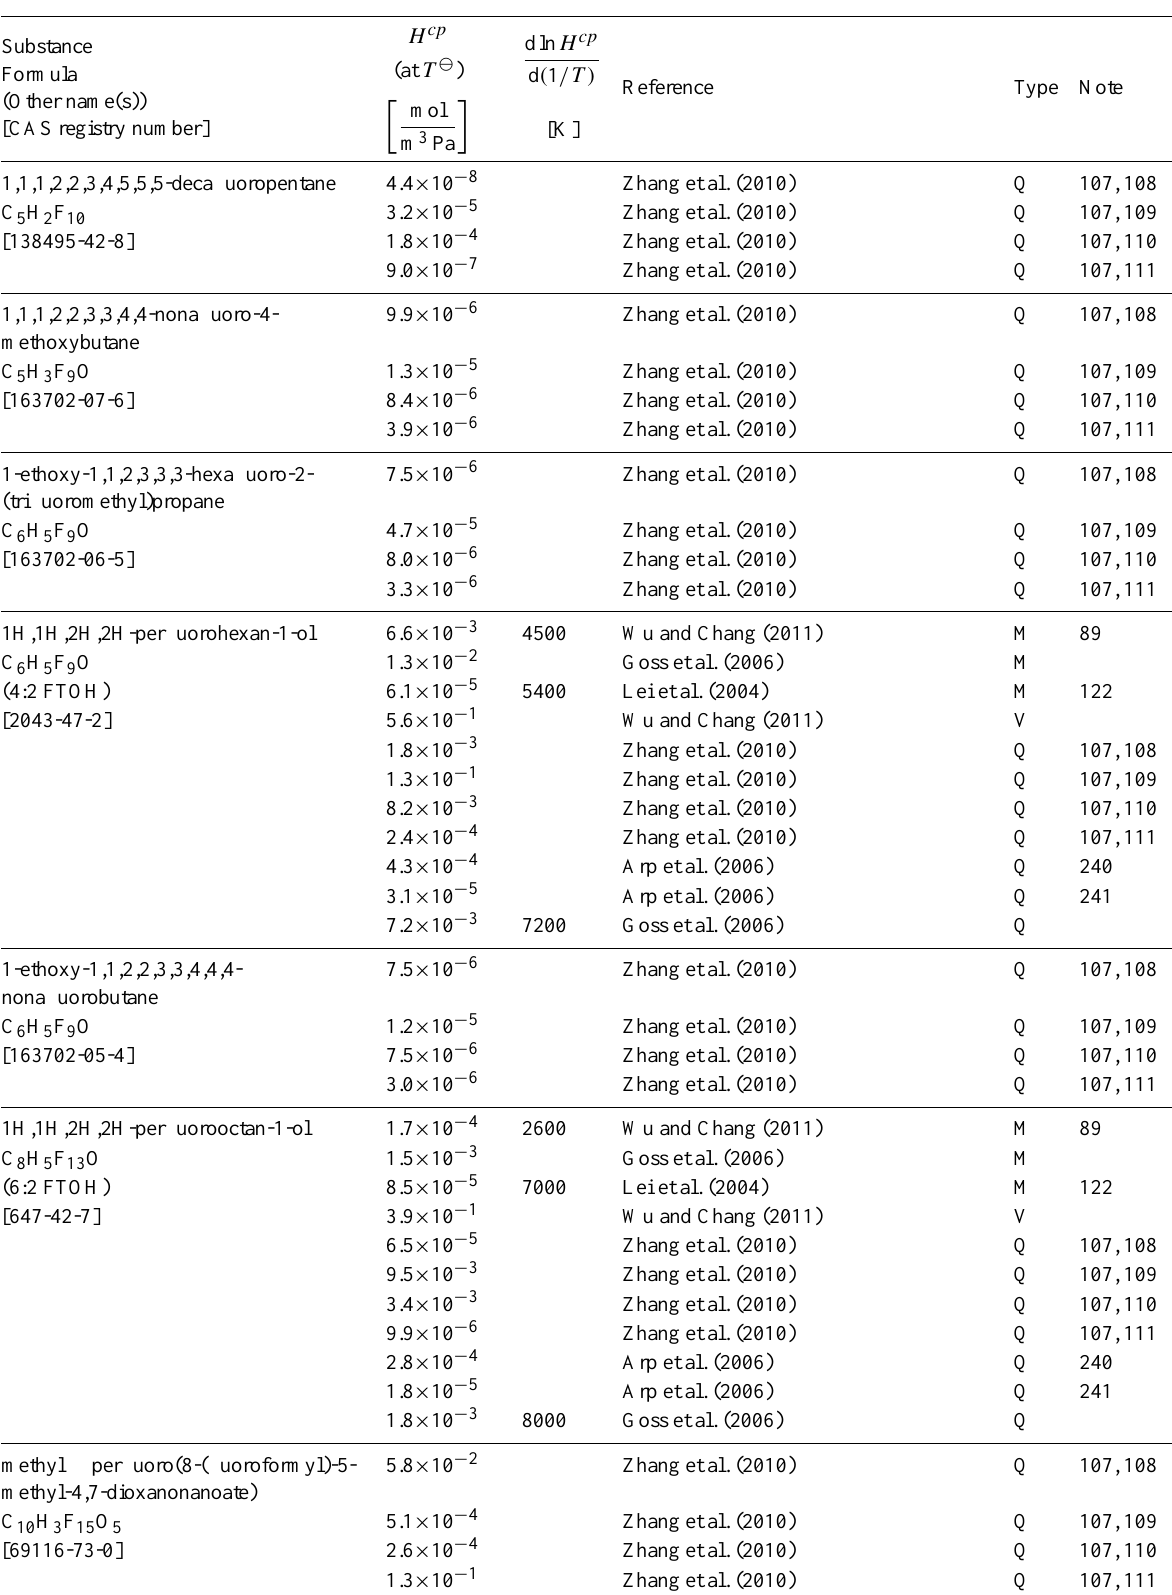
Table 6: Henry’s law constants for water as solvent